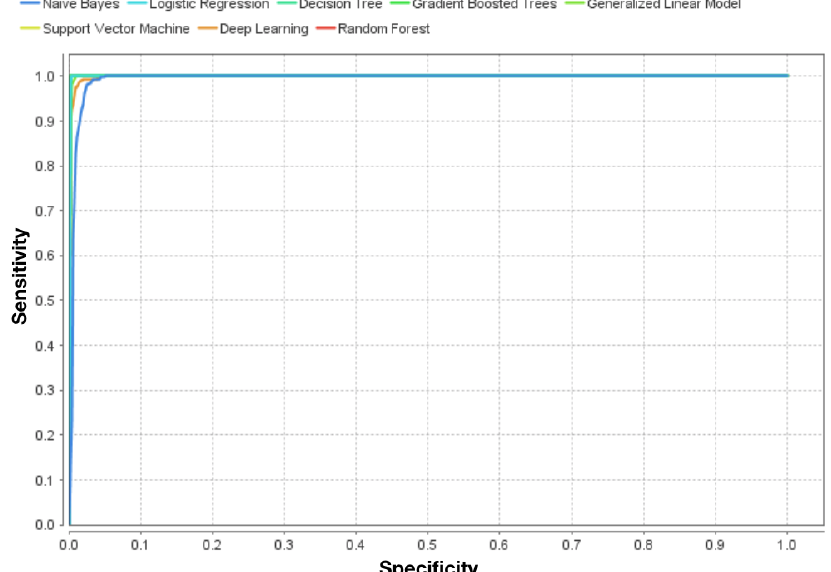
Figure 5. ROC—Classification process effectiveness—Data with similarity metrics as part of the data set. Comparison—Naive Bayes, Logistic Regression, Decision Tree, Gradient Boosted Tree, Generalized Linear Model, Deep Learning, Random